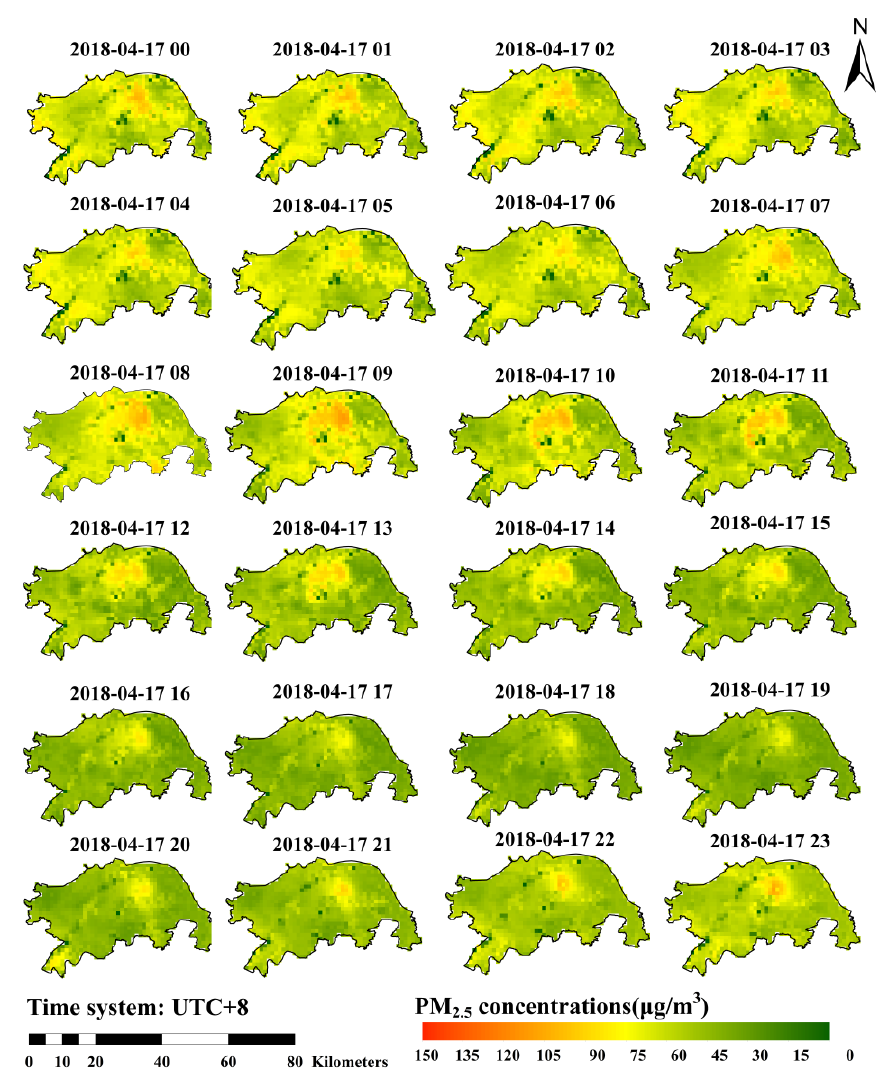
Figure 6. Spatial mapping of PM 2.5 concentration over the 24 h of a day (time system: UTC + 8), with a spatial resolution of 0.01°.